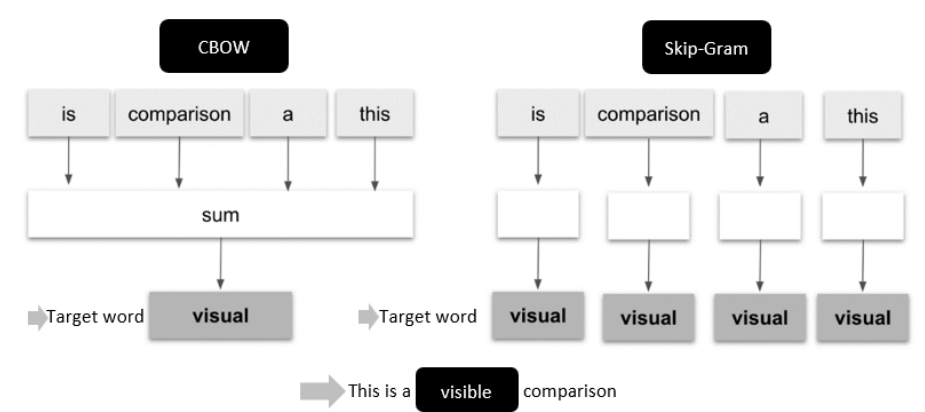
Figure 2. CBOW vs.